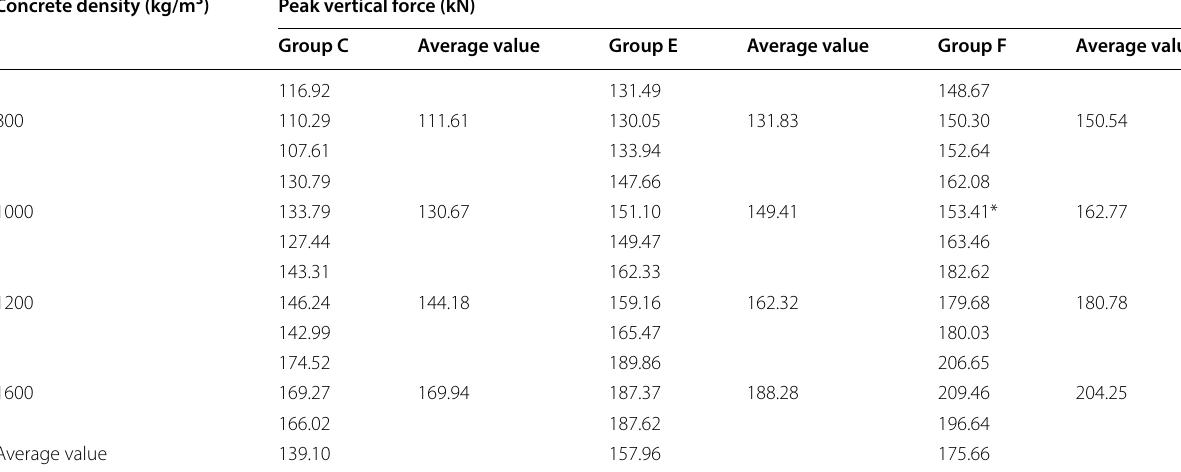
Table 3 Peak forces of test specimens.